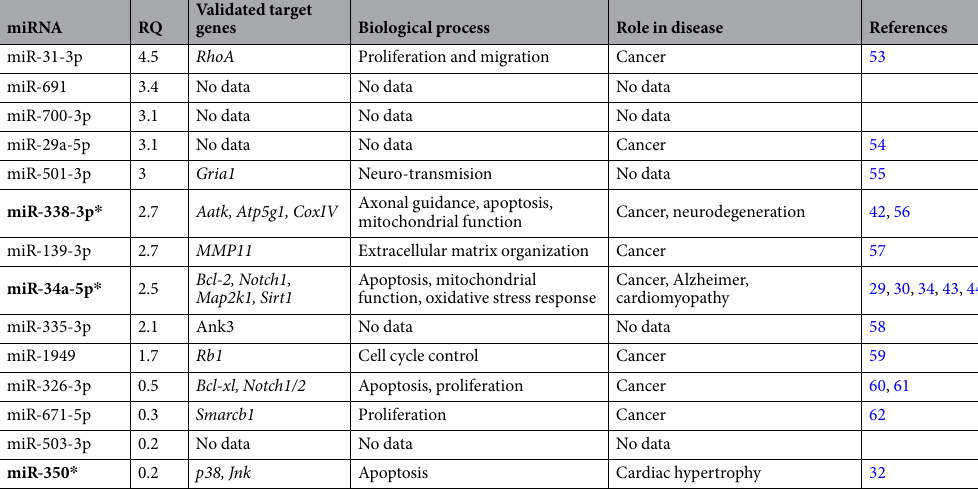
Table 1. Dysregulated miRNAs in PA mouse liver. * miRNAs selected for further